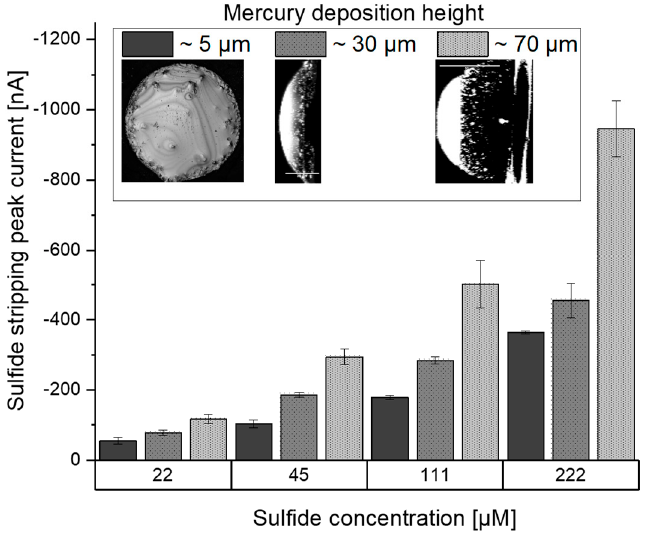
Figure 10. Electrode response during sulfide calibration for varying mercury deposition heights. Twelve consecutive measurements at a certain sulfide concentration with each electrode were performed.